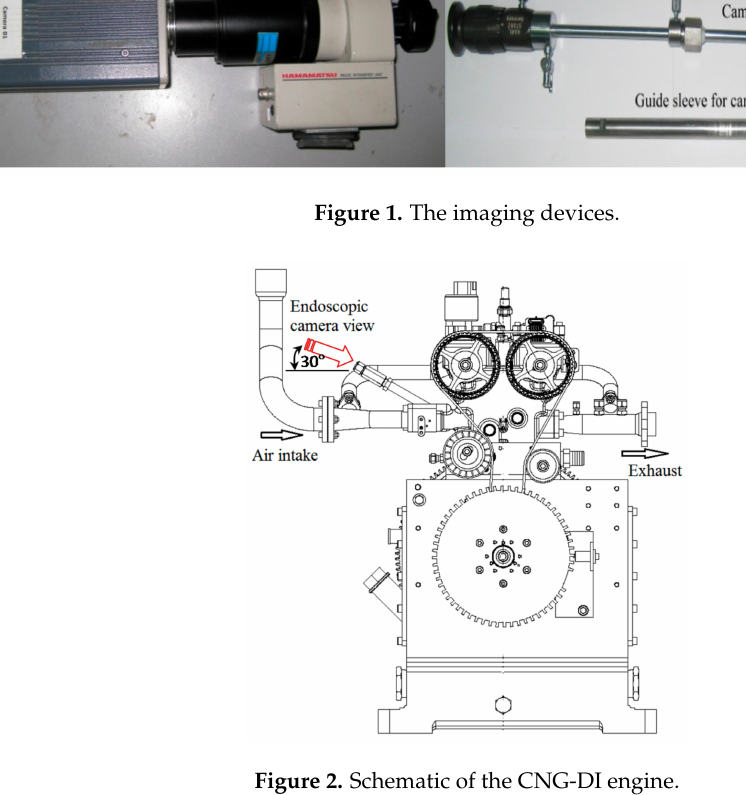
Figure 2. Schematic of the CNG-DI